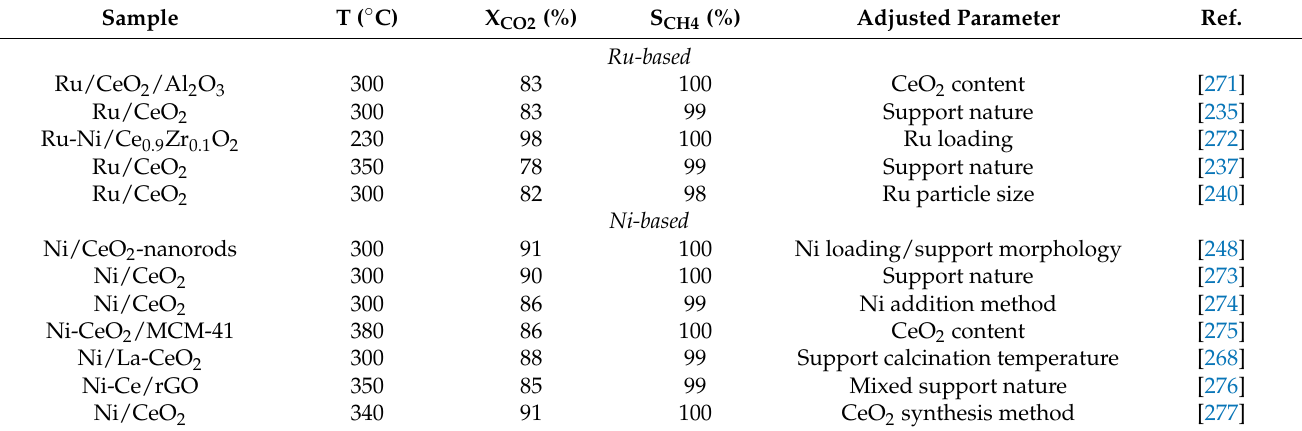
Table 3. State-of-the-art CeO 2 -based catalysts for stoichiometric CO 2 methanation at 1